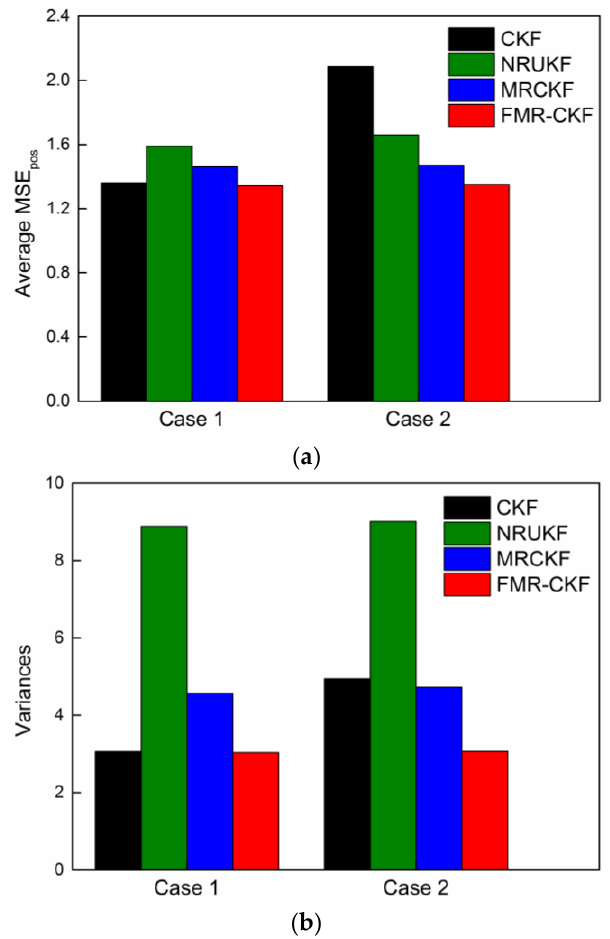
Figure 4. The MSE pos comparison of different filtering algorithms. ( a ) The average MSEs in position; and ( b )the corresponding variances.